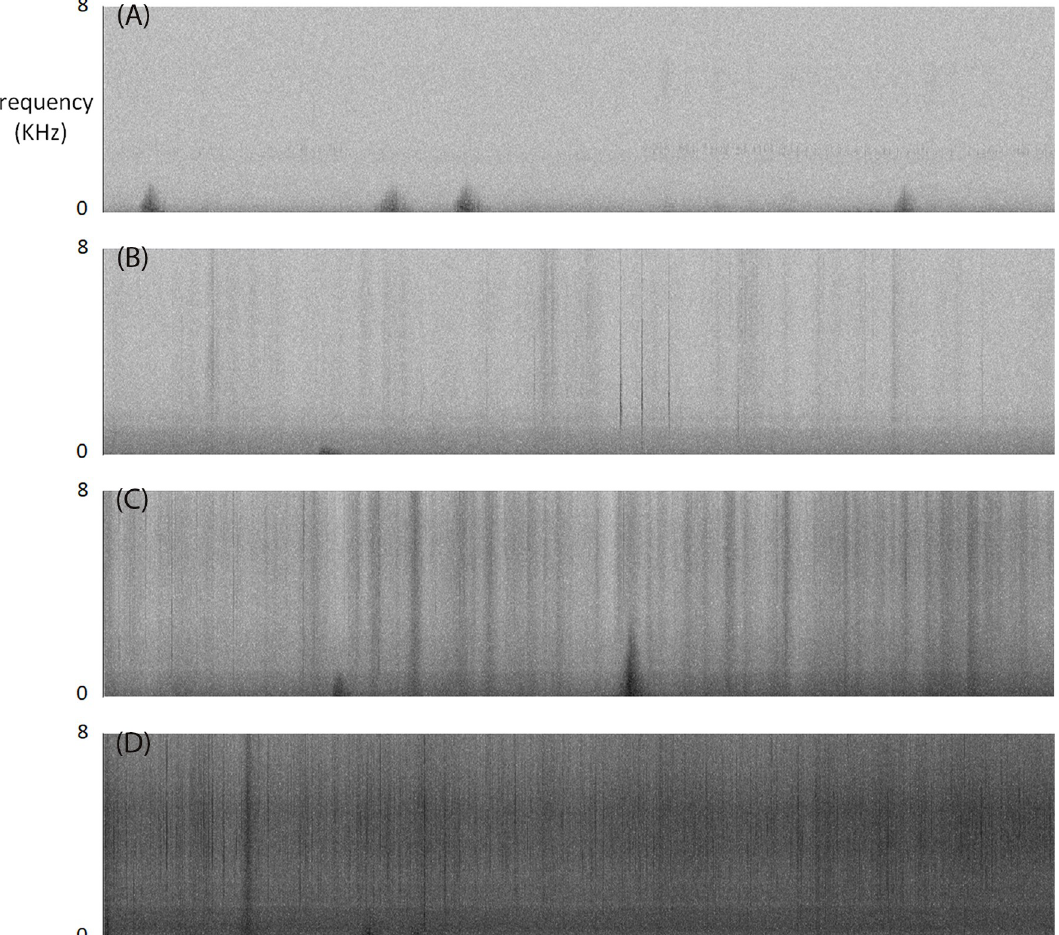
Fig 2. Spectrograms of recordings (one-hour duration) showing the influence of weather conditions on spectrogram clarity: (A) calm conditions with 0% spectrogram containing ambient noise, inclement weather score (IWS) = 0; (B) wind and rain causing ambient noise in 1–20% of spectrogram, IWS = 1; (C) wind and rain causing high levels of ambient noise in 21–50% of spectrogram, IWS = 2; and (D) wind and rain causing high levels of ambient noise in > 50% of spectrogram, IWS = 3.